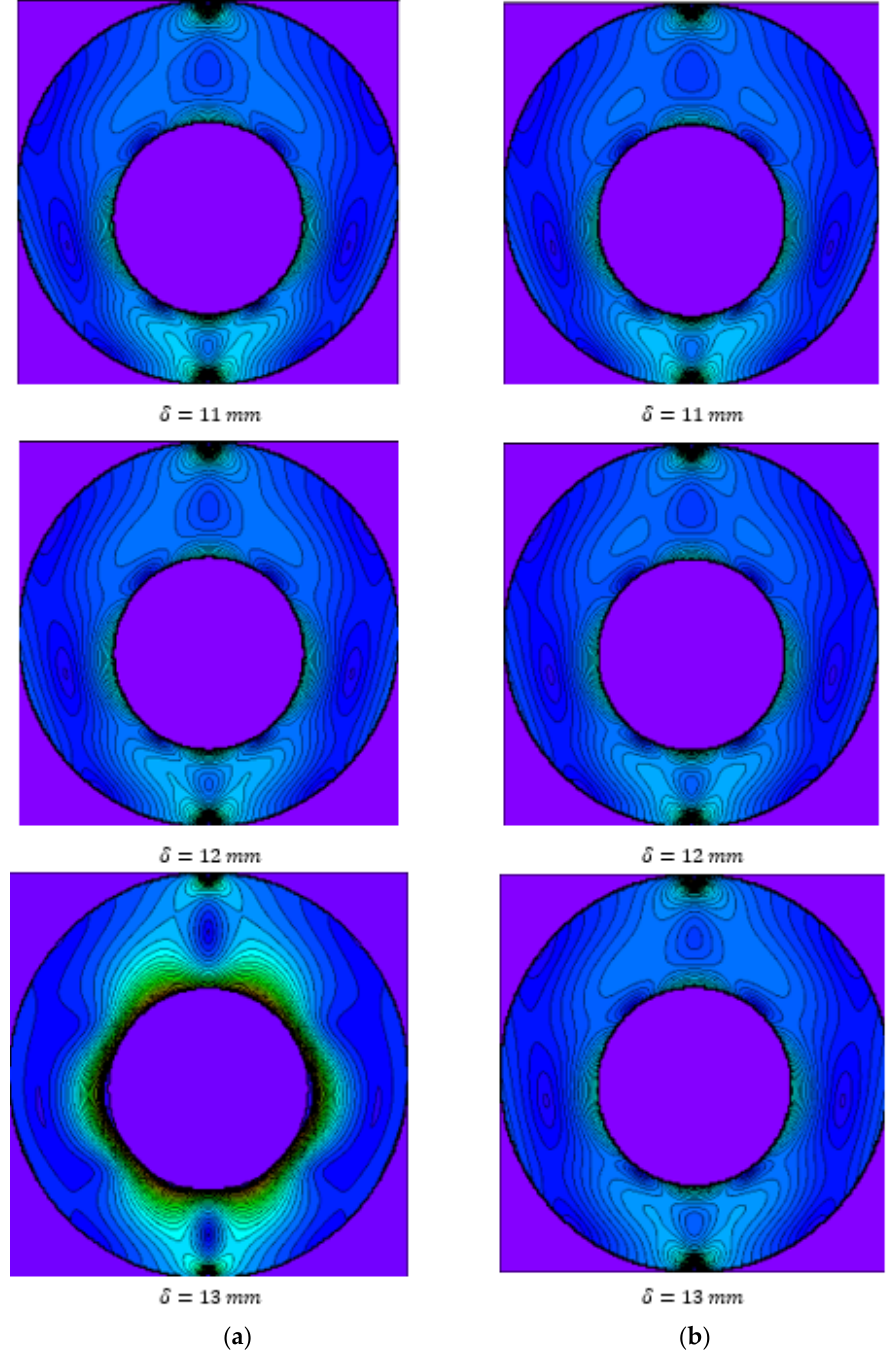
Figure 24. The effect of evaluation of the integrals from the coefficients from Fourier expansions: ( a ) numerical evaluation from the present paper; ( b ) evaluation using the closed-form solution from [72].